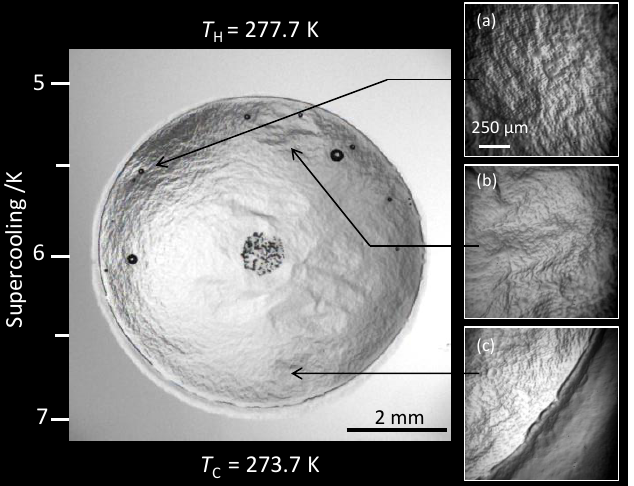
Figure 10. Detail of methane hydrate morphology from an aqueous PVP solution droplet with an applied temperature gradient. w PVP = 0.1%, p = 6.13 MPa, T L = 273.7 K, T H = 277.7 K, and T HLV = 281.4 K. ( a , b ) Wrinkled hydrate film. ( c ) Boundary between the aqueous solution droplet and the sapphire substrate.